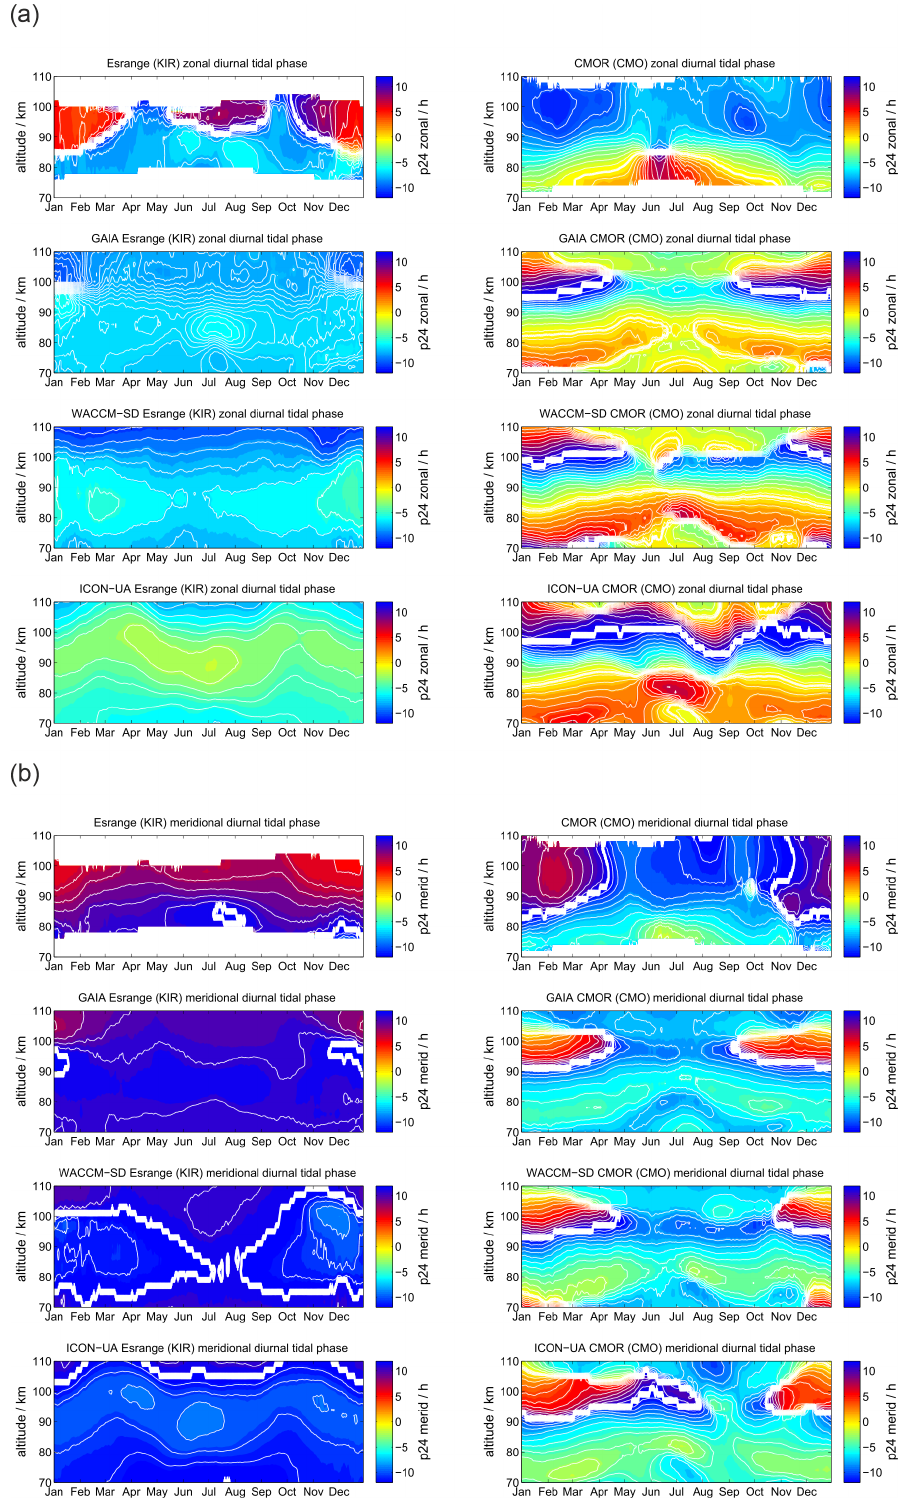
Figure A3. The same as Fig. 2, but for the diurnal tidal phases above KIR and CMO.